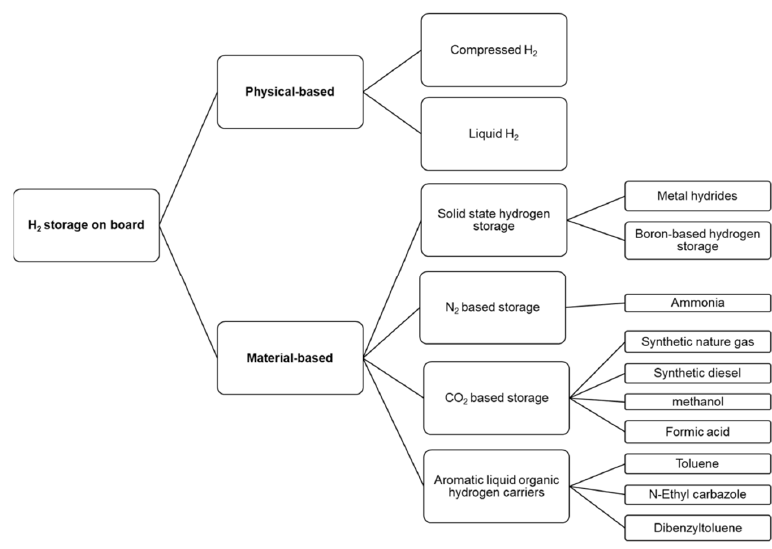
Figure 2. Potential onboard hydrogen storage technology.